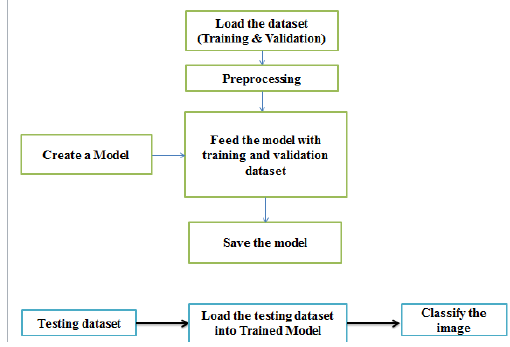
Figure 3. Training and Validation of Proposed